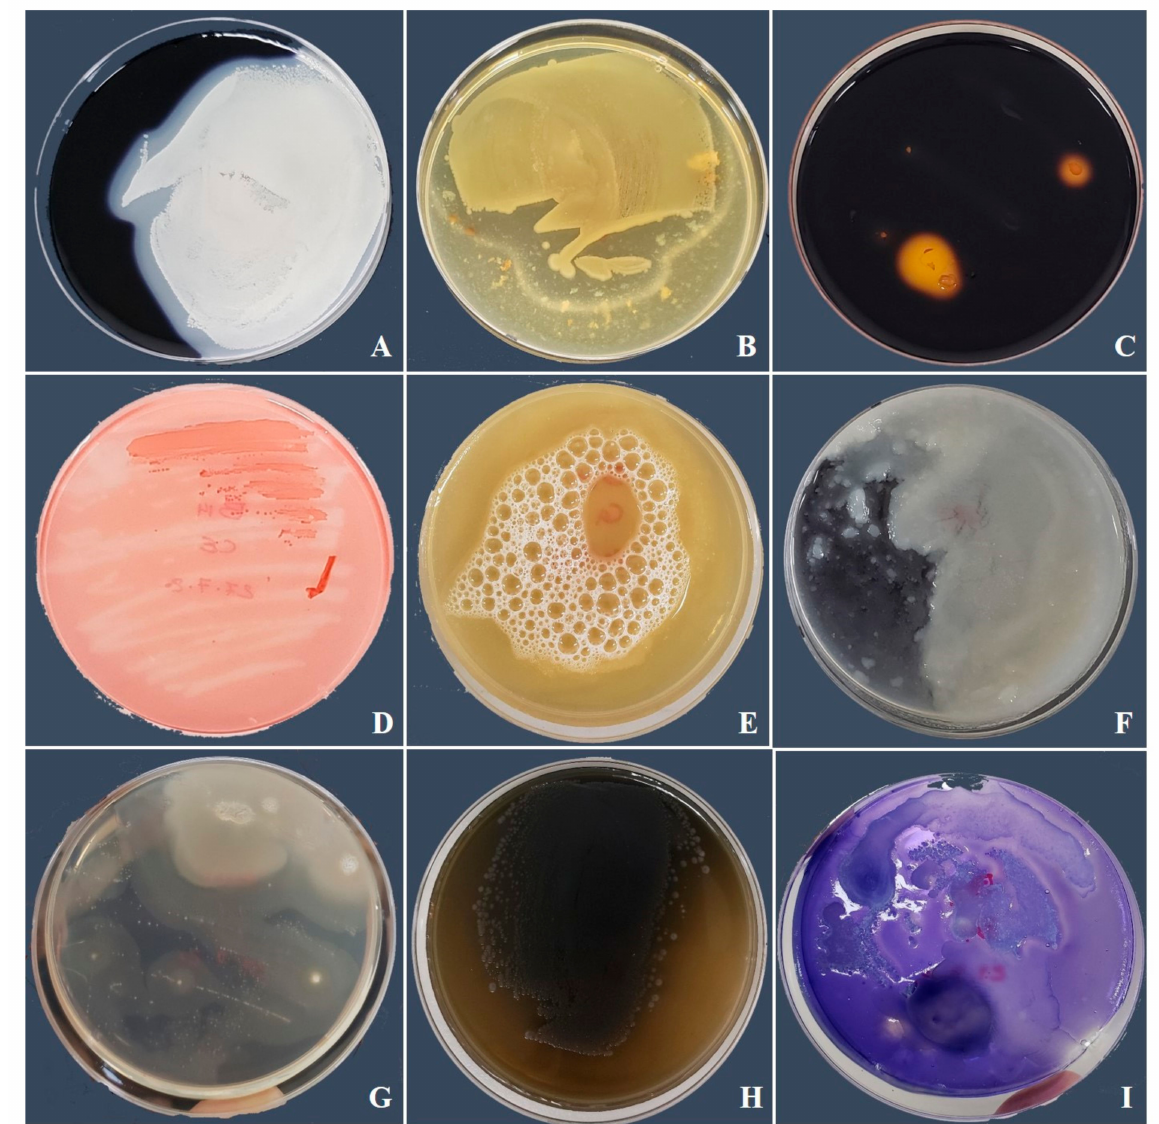
Figure 4. Hydrolytic enzyme activity of bacterial strains in this study. ( A ) Amylase, ( B ) protease, ( C ) pectinase, ( D ) cellulase, ( E ) catalase, ( F ) phytase, ( G ) lipase, ( H ) laccase, and ( I )